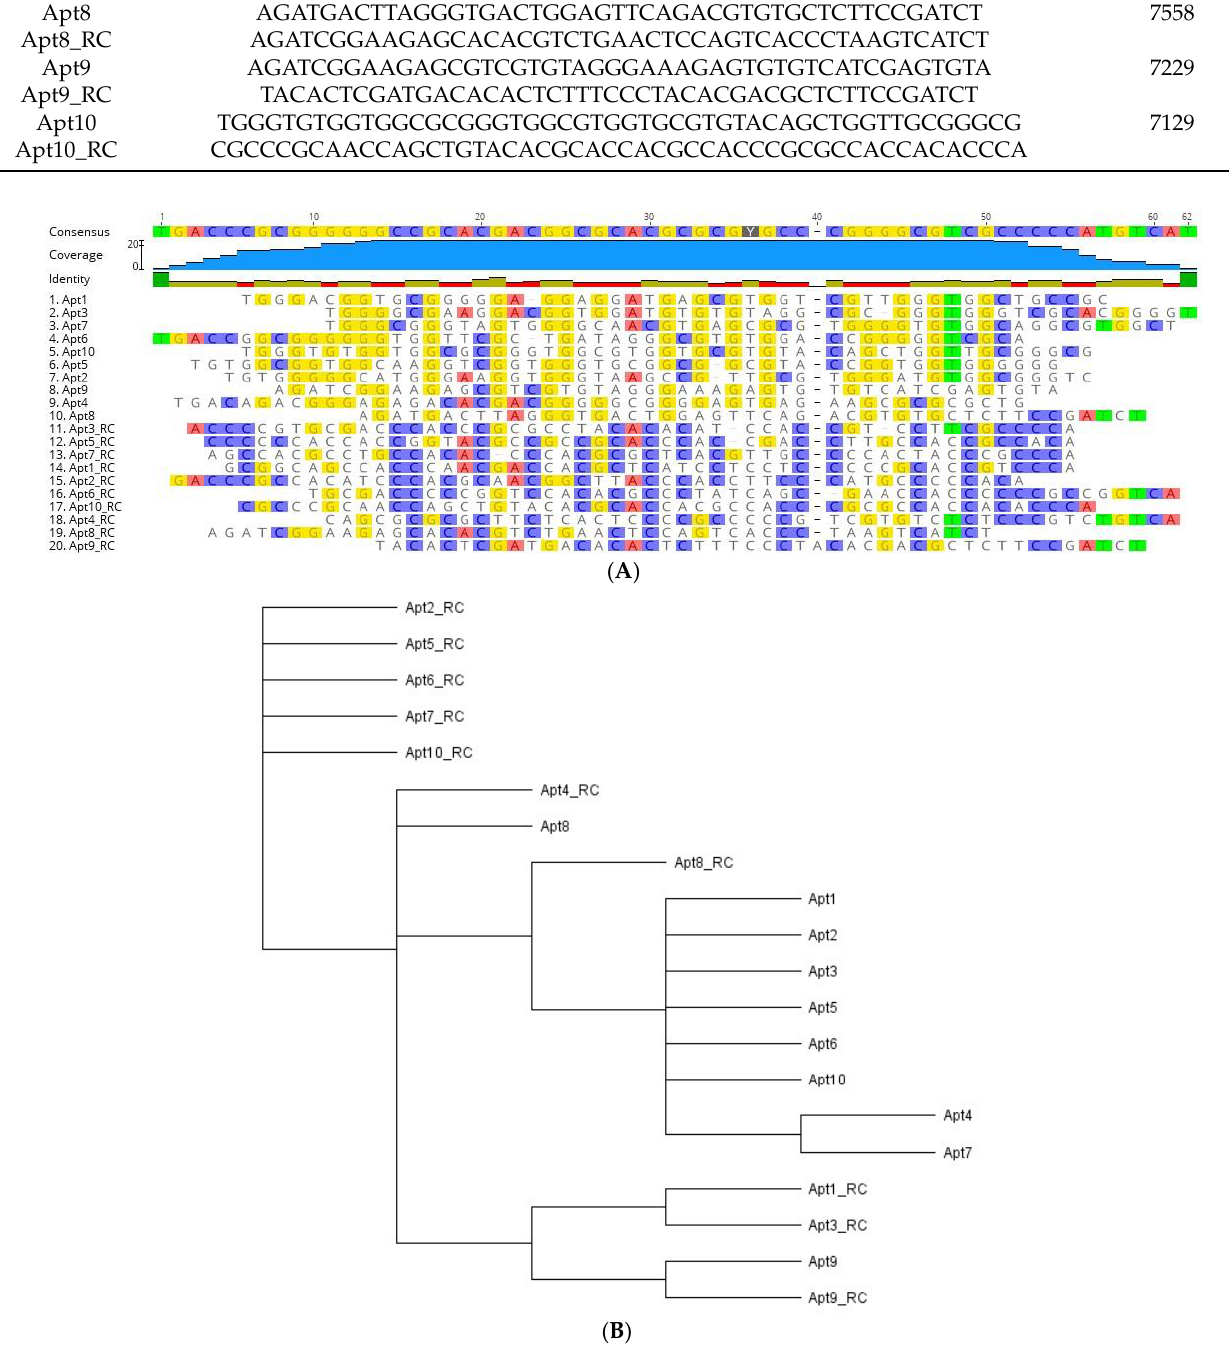
Figure 2. Sequence alignments and phylogenetic tree of the 20 aptamer sequences obtained after bioinformatic analysis. ( A ) Sequence alignments of the random region from the ten most frequent aptamer sequences and their reverse complement (RC) sequences obtained after NGS of the final aptamer pool of cell-SELEX. The regions of homology in the sequences are highlighted. ( B ) Phylogenetic relationship of the aptamer sequences using ‘Tree Builder’ in Geneious software. The relationship between the sequences was determined using a neighbor-joining model with no outgroups.